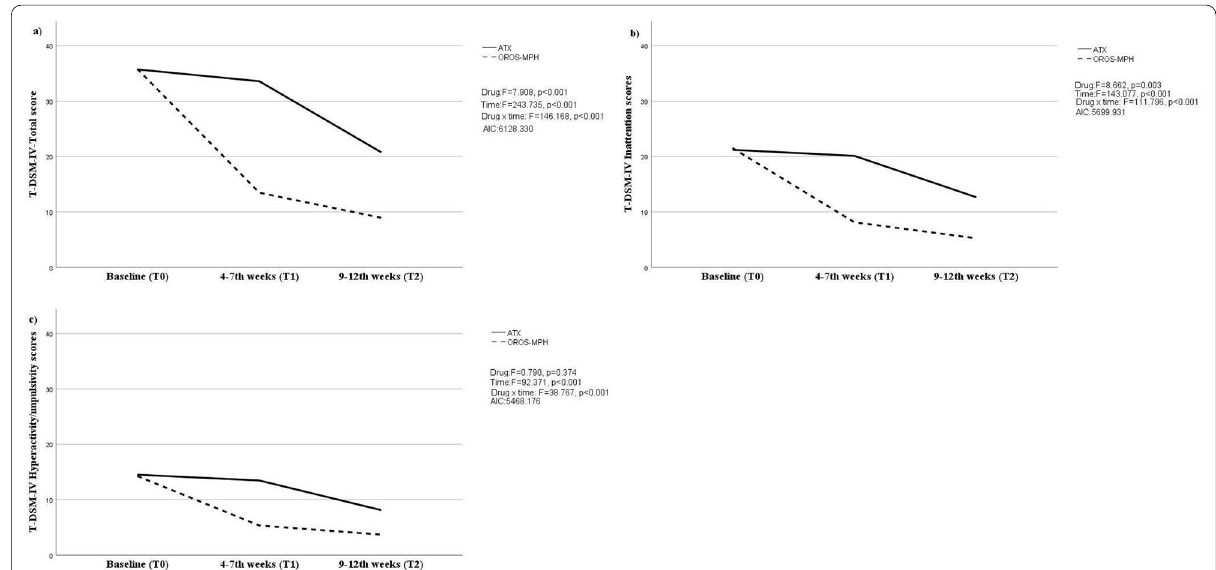
Fig. 2 Line chart depicts the result of mixed-model repeated-measures analysis of ADHD symptom severity. † ATX atomoxetine, OROS-MPH osmotic-release oral delivery system methylphenidate, T-DSM-IV-S the Turgay DSM-IV disruptive behavior disorders rating scale, AIC Akaike information criterion. a Is total score, b is inattention score, and c is hyperactivity/impulsivity